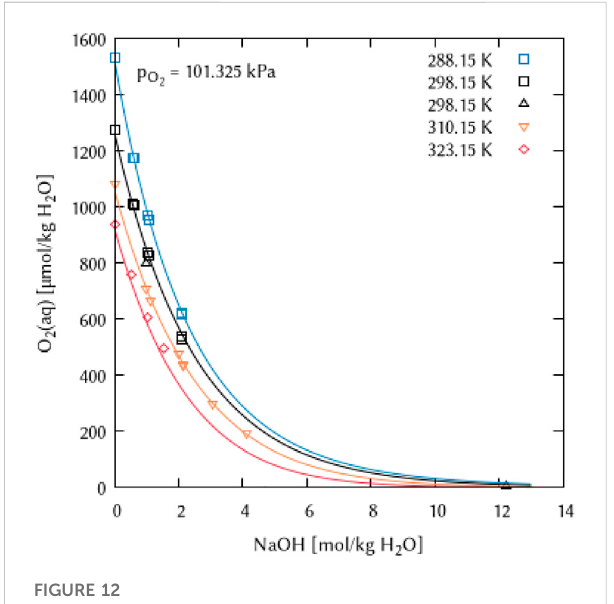
FIGURE 14 Modelling of the O 2 solubility in hydrochloric acid solution as a function oftemperatureand HCl concentration. (Points:Experimental data from □ Geffcken (1904) and ○ Lang and Zander (1986), Lines: this work).